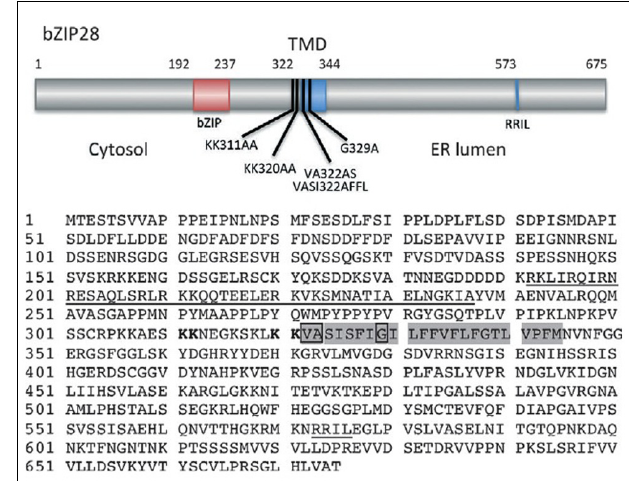
FIGURE 2 | Map (above) of Arabidopsis bZIP28 showing its cytosolic, transmembrane (TMD) and lumenal domains. Also shown are the locations of the bZIP region in the cytosolic domain, the canonical S1P recognition site (RRIL) in the lumenal domain, several alanine substitution mutations and a deletion mutation (bZIP28 (cid:2) 355) described in the text. Amino acid sequence of bZIP28 (below) highlights the bZIP domain and S1P recognition site (both underlined), theTMD in which theVASI sequence and helix-breaking G residue are boxed. Paired lysines involved in Sar1b binding and Golgi relocalization are indicated in bold. (Figure based on Srivastava etal.,